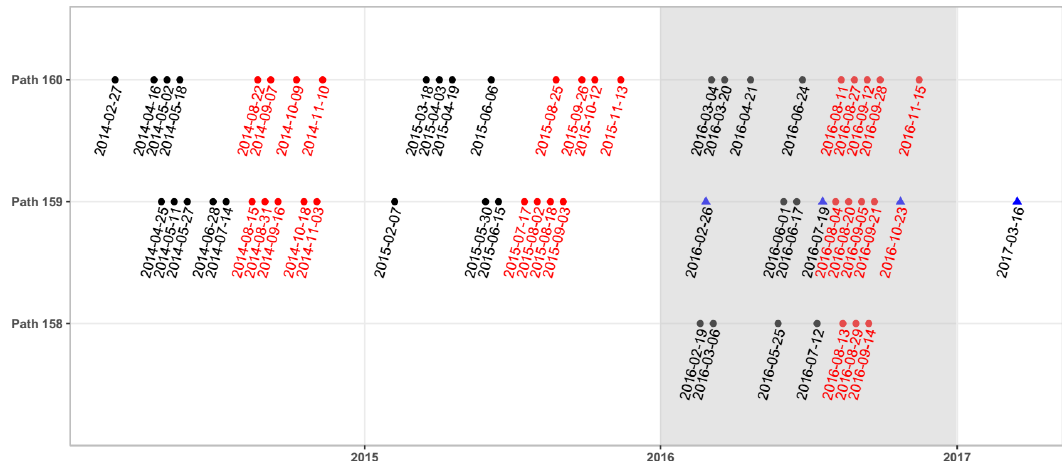
Figure 3. List of L8 data used in this study over five tiles. The dates in black were used for extracting summer crop area and those in red were used for winter crop area. The blue points represent dates used to develop RF models. The dates given in gray area for the year 2016 were used for developing the LULC map. Note that L8 data from path 158 were used only for LULC map and the data acquired on 16 March 2017 were used only for developing RF